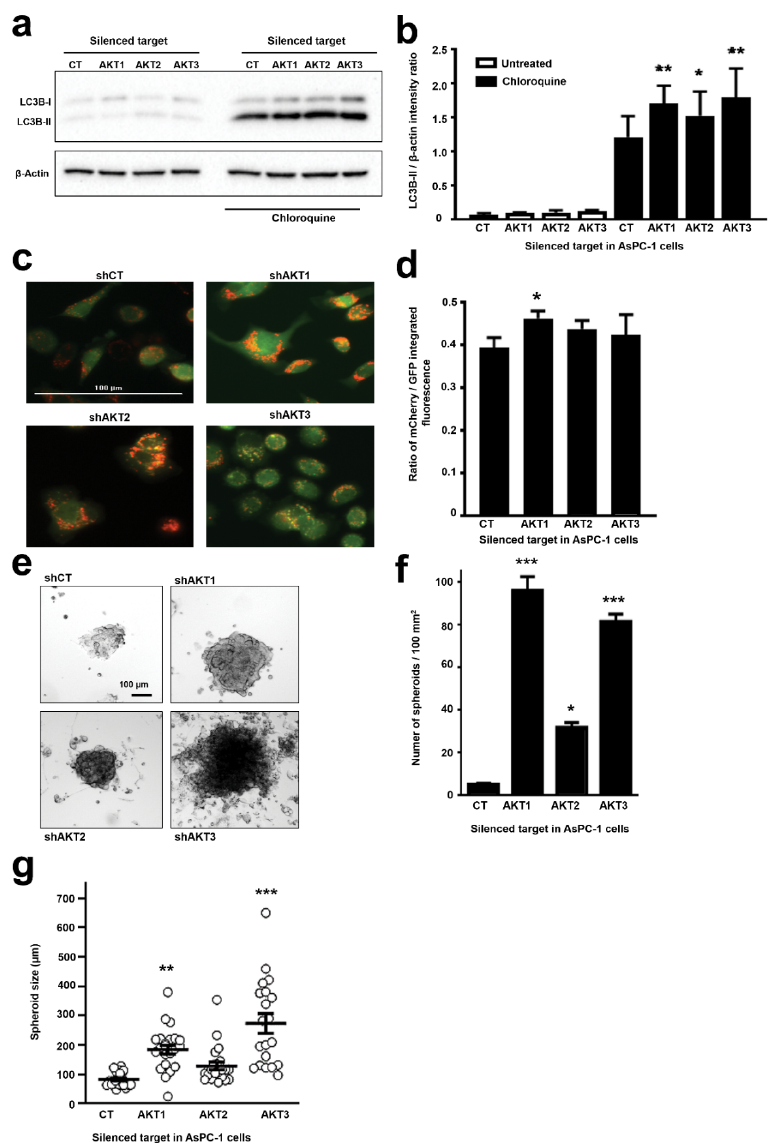
Figure 6. Adaptation of AsPC-1 cells to silencing of AKT isoforms increase autophagy and spheroid growth. ( a ) Western blot with expression of LC3B-I and II forms as indicated in the shown cell lines with or without incubation with chloroquine. Original uncropped Western blots and densitometry readings are shown in the Figures S12 and S13. ( b ) Bar graph with the ratio of intensities for LC3B-II versus β -actin as determined by densitometry of Western blots as in ( a ). Ratios were obtained from triplicates. Statistical comparisons were performed by ANOVA and pairwise Tukey´s tests between AKT-silenced and control groups. ( n = 3). ( c ) Fluorescence microscopy of living AsPC-1-mCherry-GFP-LC3B cells with silenced AKT isoforms as indicated, or control cells expressing an irrelevant control shRNA (shCT). Representative 20 × pictures with merged GFP and mCherry fluorescence. Autophagolysosomes correspond to bright red vesicles. ( d ) The bar graphs represent the ratio of mCherry / GFP mean fluorescence intensities ( n = 4). Statistical comparisons were performed by ANOVA and pairwise Tukey´s tests. ( e ) Representative phase contrast pictures of spheroids formed from the indicated AsPC-1 cell lines. ( f ) Bar graph shows the number of spheroids per 100 mm 2 obtained from the indicated cell lines. ( g ) Bar graph shows the spheroid size ( n = 20) from the indicated cell lines. Statistical comparisons were performed by ANOVA and pairwise Tukey´s test by comparing to control shCT-AsPC-1 cells. *, **, ***, indicate significant ( p < 0.05), very significant ( p < 0.01) and highly significant ( p < 0.001) di ff erences. CT, control